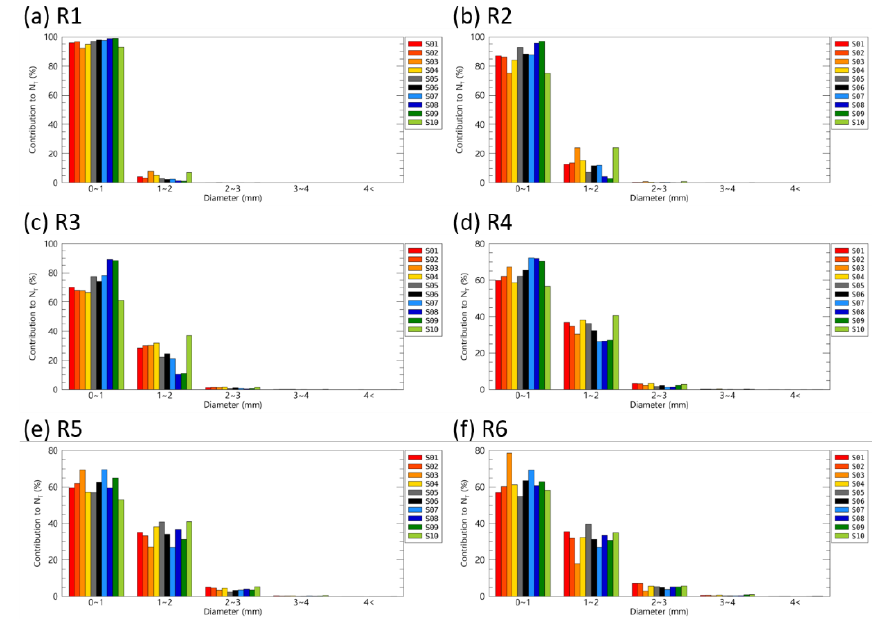
Figure 6. The contribution rate of the N(D) of each diameter category to N T . When the rain rate was less than 5 mm h −1 , raindrops larger than 1 mm at S3 had a high contribution to the rain rate compared to other sites (Figure 7a,b). In contrast to the S3 site, the S8 and S9 sites had less than 30% of raindrops larger than 1 mm, so the raindrops constituting the rain rate were mainly composed of very small drops of less than 1 mm (Figure 7a). In the coastal areas, the raindrops mainly contributing to the rain rate increase were 2 – 3 mm, but in the mountain slopes, the contribution rate of middle side raindrops of 1 – 3 mm was higher (Figure 7e,f). Depending on the mountainous area, there is a difference in the diameter of raindrops that affects precipitation. Due to the difference in particle diameter and N(D) distribution, differences in rainfall estimation relations with reflectivity parameters may occur between sites.